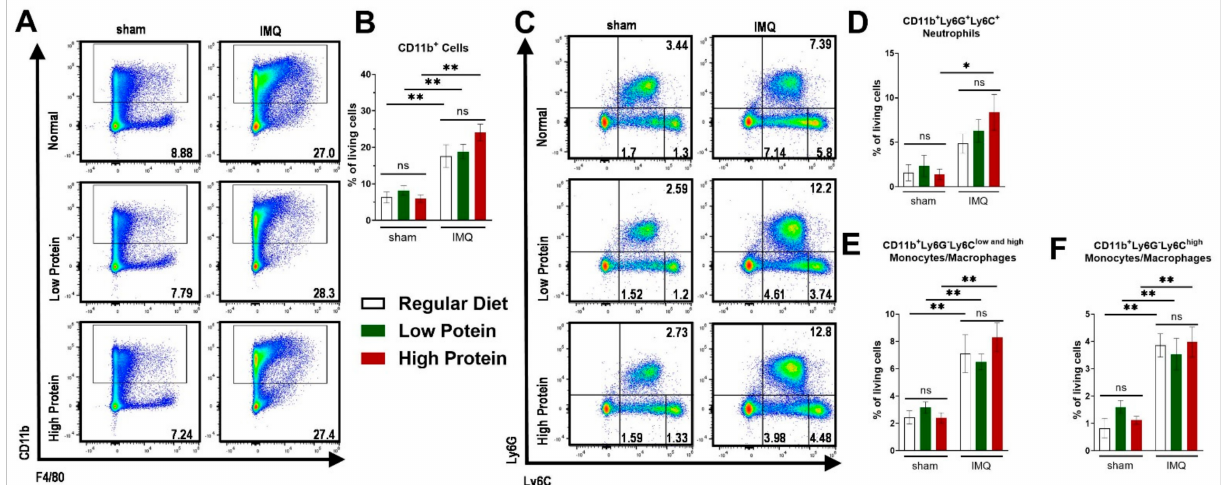
Figure 4. Modulation of dietary protein has no effects on IMQ-driven expansion of myeloid cells in the spleen. Flow cyto- metric analysis of spleen cells after sham or IMQ-treatment in mice on a regular, low, or high protein diet. ( A ) Representative flow cytometric plots of spleen cells from sham or IMQ-treated-mice on a regular, low, or high protein diet. ( B ) Quantification of CD11b + myeloid cells. To determine CD11b + myeloid cells, cells were pre-gated on living CD45.2 + cells ( n = 4–13; Kruskal– Wallis test). ( C ) Representative flow cytometric plots gated on Ly6G and Ly6C are shown for each group. ( D ) Quantification of CD11b + Ly6G + Ly6C + neutrophils ( n = 4–13; Kruskal–Wallis test). ( E ) Quantification of CD11b + Ly6G − Ly6C low and high monocytes/macrophages and ( F ) the subset of CD11b + Ly6G − Ly6C high monocytes/macrophages in the spleen after sham or IMQ-treatment in mice on regular, low, or high protein diet ( n = 4–13; Kruskal–Wallis test). Data are shown as mean ± SEM. ** p < 0.01; * p <